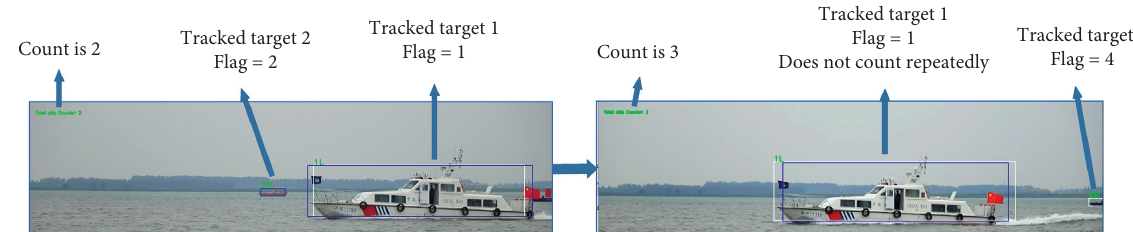
Figure 2: Ship counting principle.